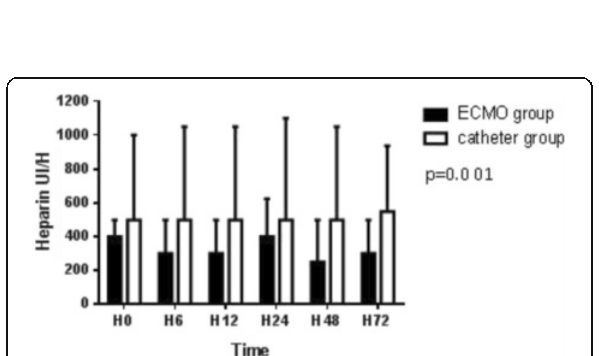
Fig. 133 (abstract A332). Heparin doses during CVVH (median with